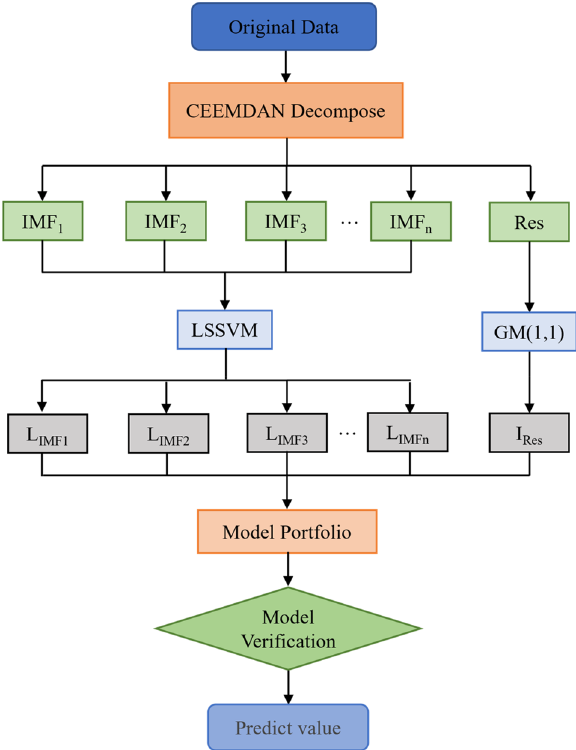
Figure 2. Flow chart of CEEMDAN–LSSVM–GM(1,1)